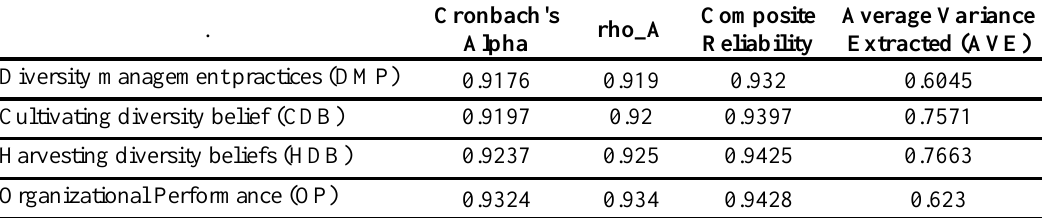
Table.2. Composite Reliability (CR), Cronbach’s Alpha and AVE